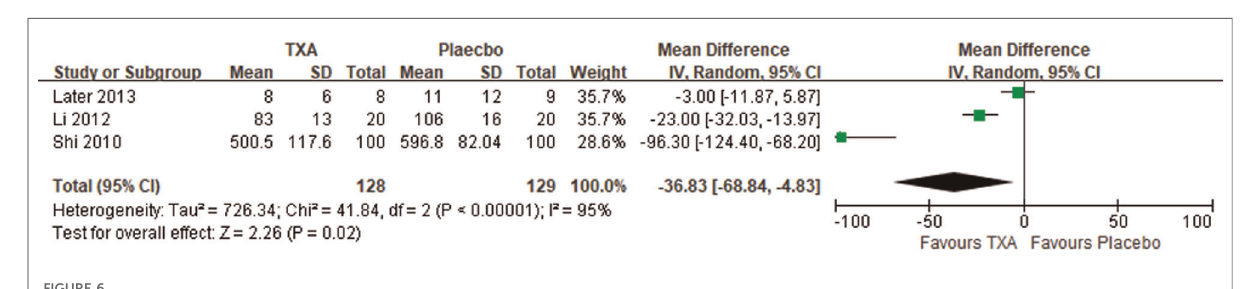
FIGURE 6 Forest plot comparing TXA and placebo for the postaperative 24 h IL-8